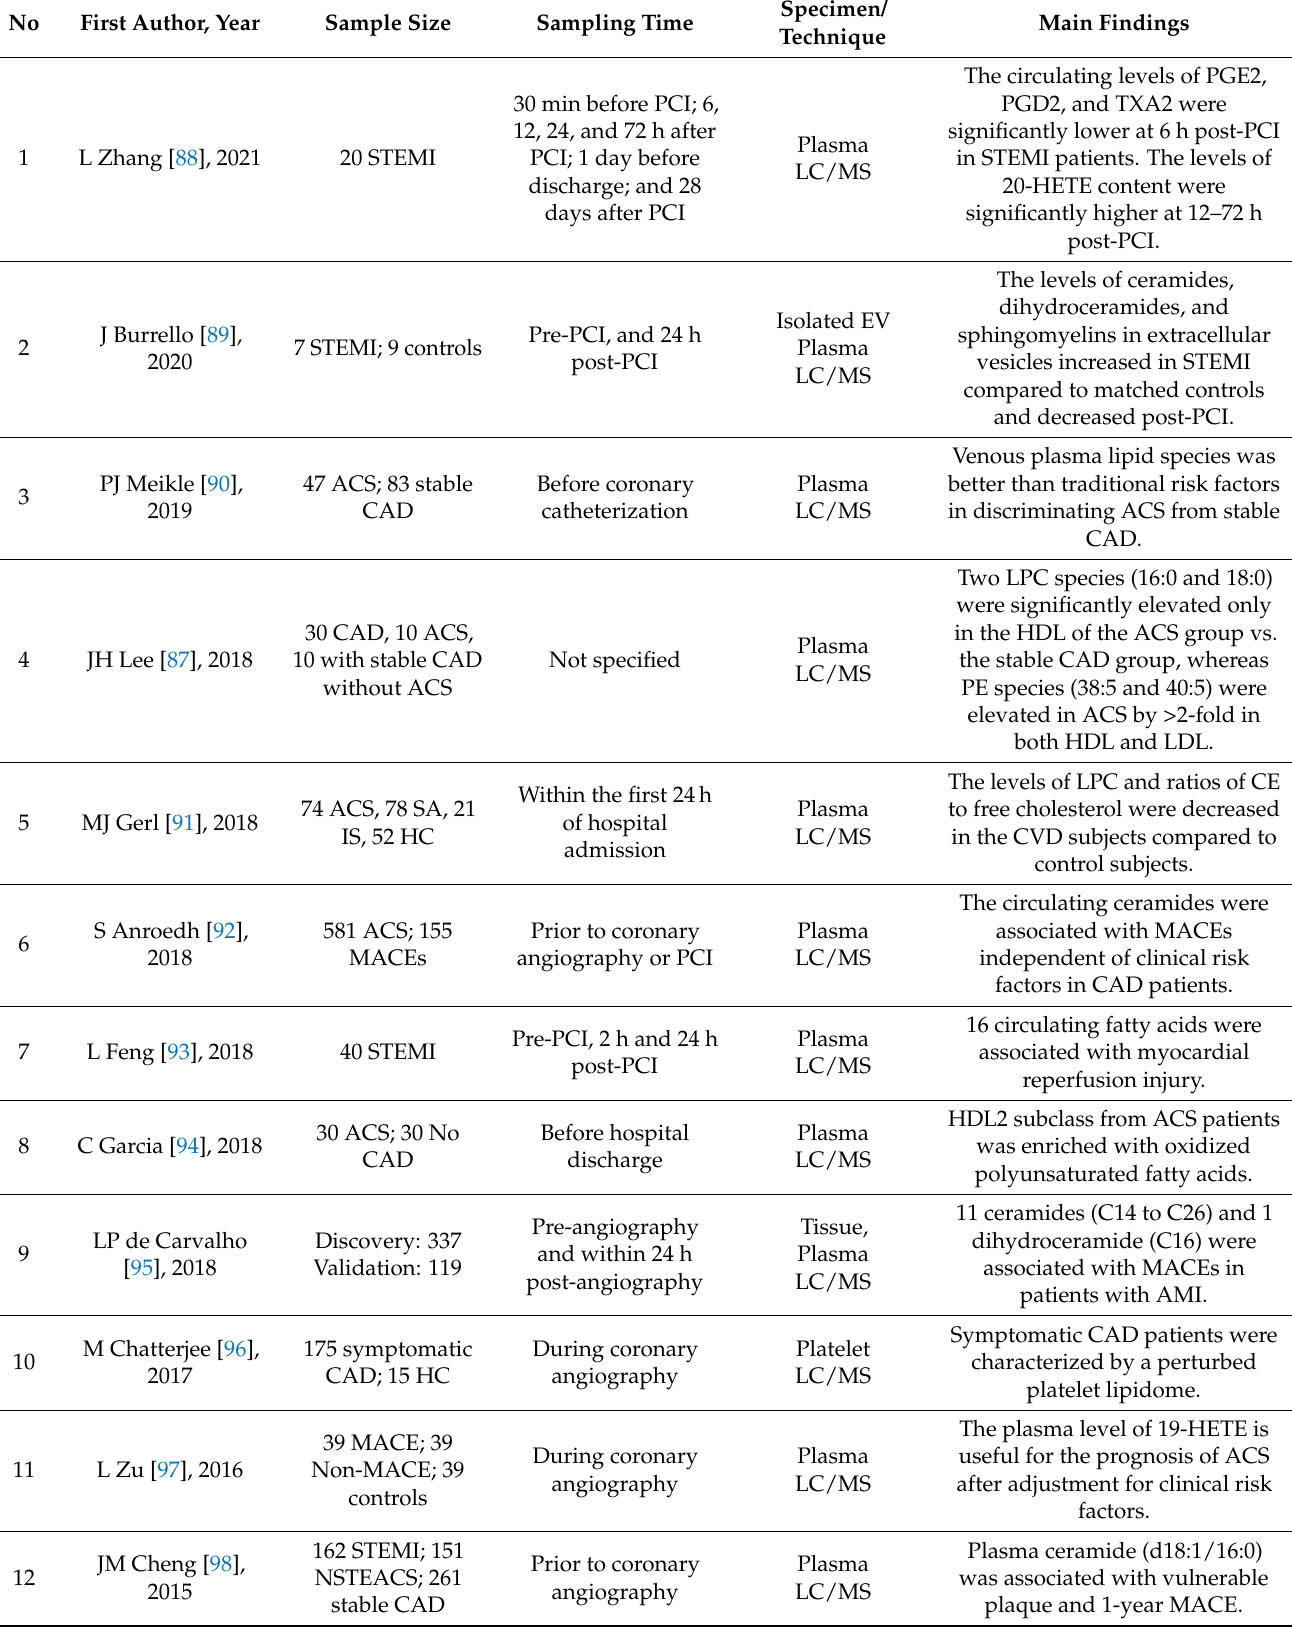
Table 3. Main findings from the clinical studies of lipidomics in acute coronary